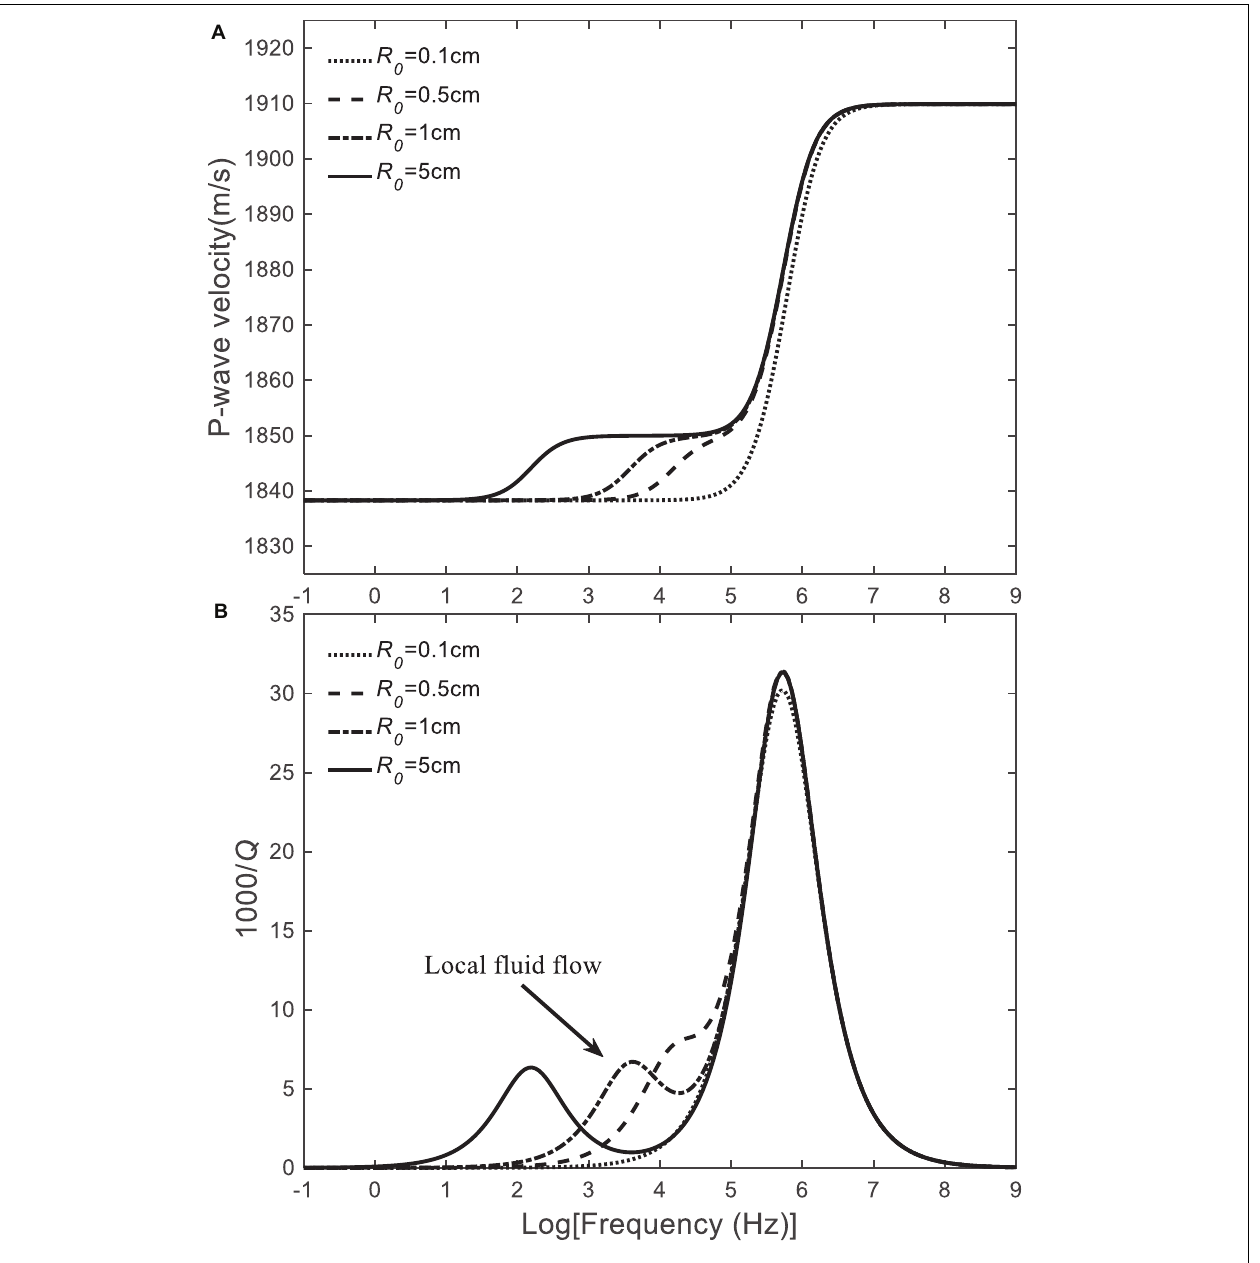
FIGURE 5 | Model 1. P-wave velocity (A) and dissipation factor (B) as a function of frequency for different inclusion radii of hydrate/gas. The hydrate concentration is 20%, and the porosity is 40%.